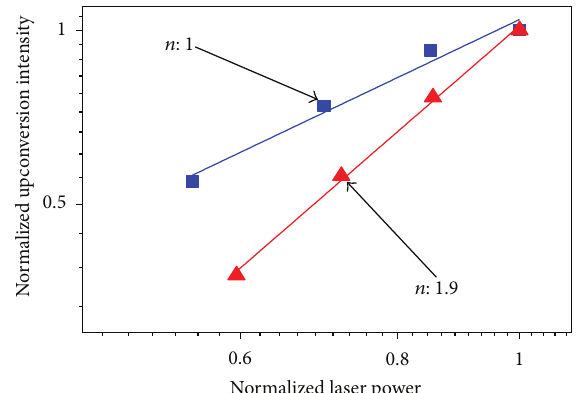
Figure 21: Integrated luminescence intensity as a function of the laser intensity